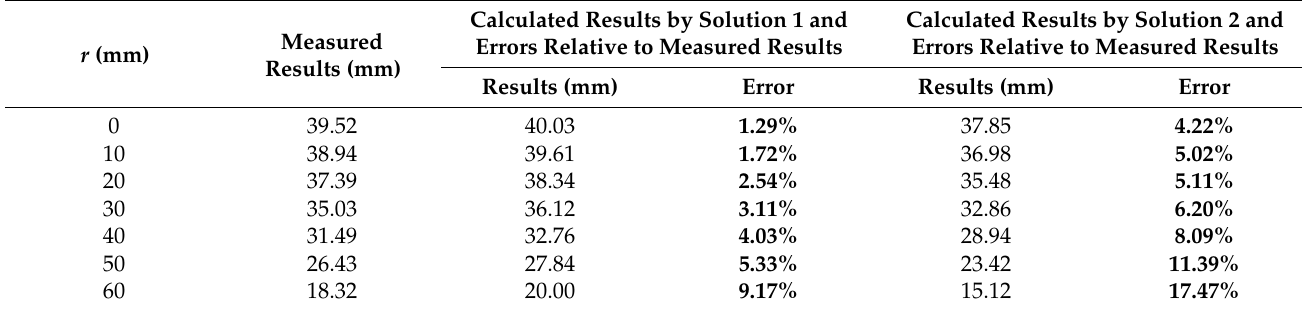
Table 3. The measured and calculated results of membrane deflection and their relative